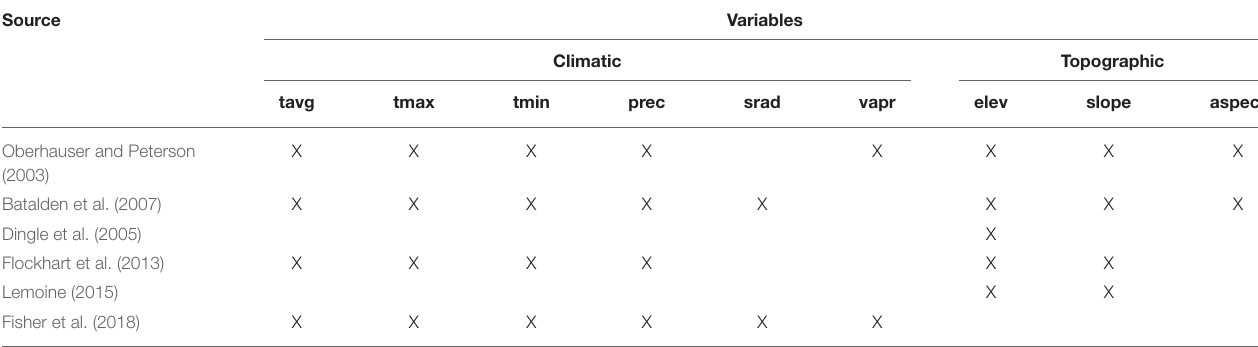
TABLE 1 | List of climatic and topographic variables used in our study and in previous studies to model monarch butterfly distribution; tavg, average temperature; tmax, maximum temperature; tmin, minimum temperature; prec, precipitation; srad, solar radiation; vapr, water vapor pressure; elev, elevation; slope, slope; aspect, aspect. Source Variables Climatic Topographic tavg tmax prec srad vapr elev slope aspect